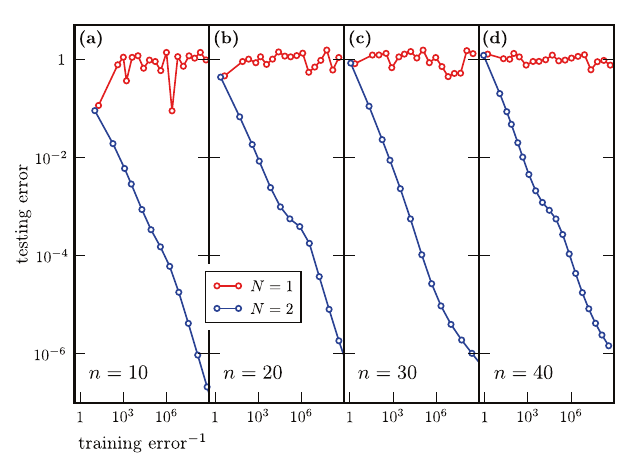
Fig.4|Performanceofvariationalunitarycompilingwheninitializingnearthe solution. Eachpanelshowstheresultsofasinglerandomlyinitializedtrainingrun, whereweusedrandomlydrawnlow-entangledstatesfortraining.Thetestingerror on20teststates,whichweallowtobemorestronglyentangledthanthestatesused during training, is plotted versus the reciprocal of the training error for training data sizes N =1,2, for differentsystem sizes n . Atraining dataset of size N =1 isnot suf fi cient to guarantee good generalization: Even with decreasing training error, the testing error remains large. In contrast, assuming favorably initialized training, N =2 training data points suf fi ce for good generalization, even for up to n =40